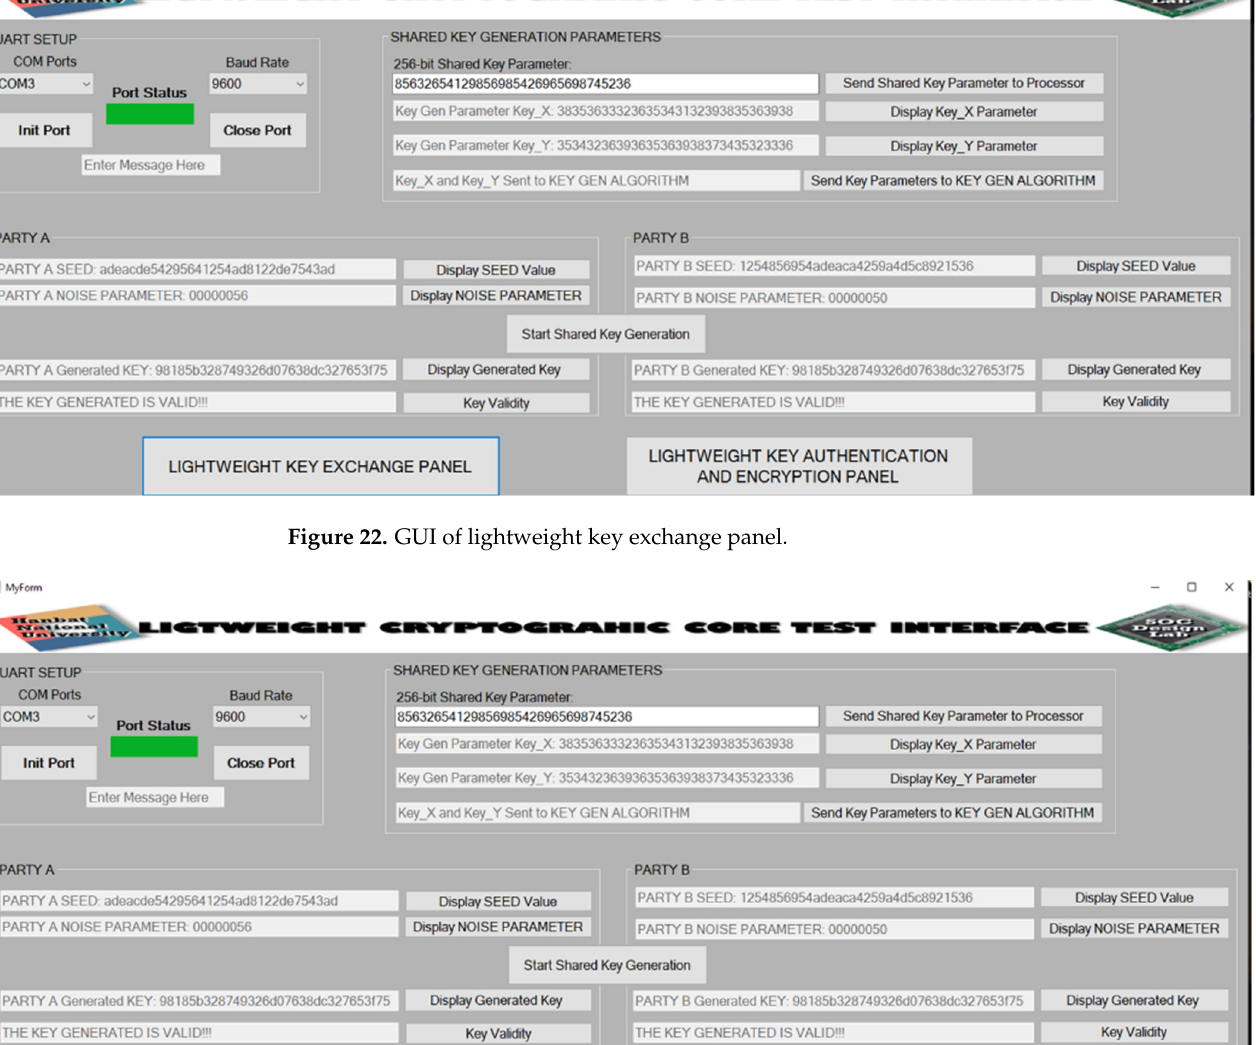
Figure 23. GUI of the lightweight key authentication and encryption/decryption panel.